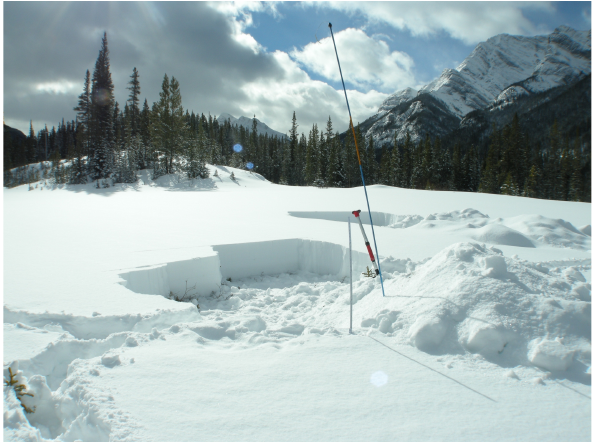
Fig. 2. Desired vertical overlap in thermal images, balancing the issues of area measured, time exposed, and lens error. The first image ideally would occur with the area of interest centered. To more completely assess surface changes over time at the area of interest, multiple images at position (1) can be taken.